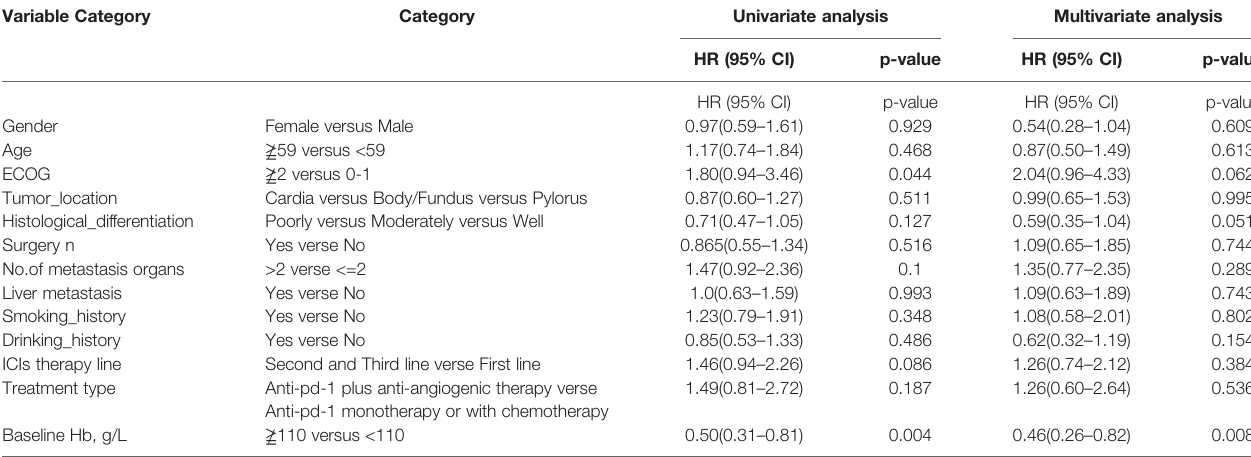
TABLE 3 | Univariate analysis and multivariate analysis of clinical variable for the prediction of progression free survival of AGC patients treat with anti-pd-1 inhibitors. Variable